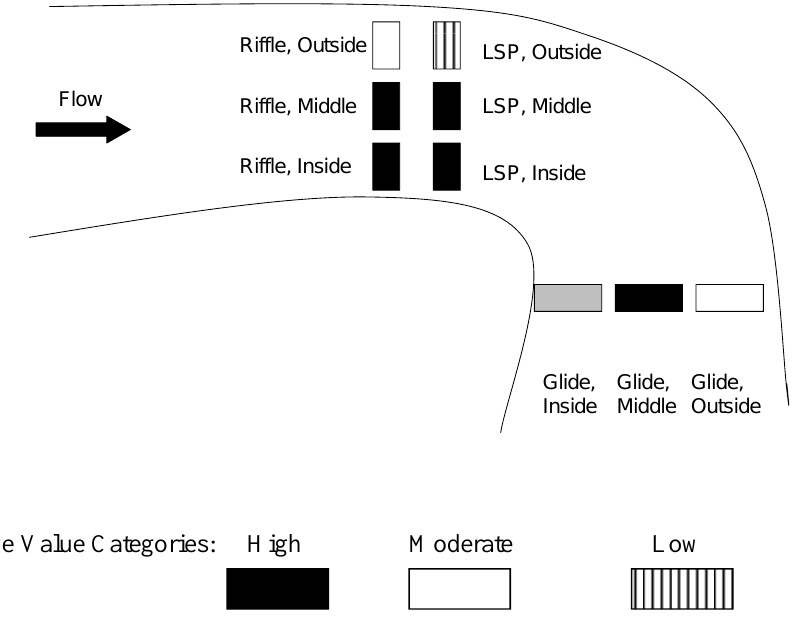
Figure 6. In situ depiction of three seasons of mean bedload discharge (Q bl ; gs −1 ) by habitat (Run, Lateral Scour Pool (LSP), Glide) x lateral position (Inside, Middle, Outside). The mussel bed is located at LSP/Outside, which has low mean Q bl . The relative value categories compare all cells habitat x lateral position interaction